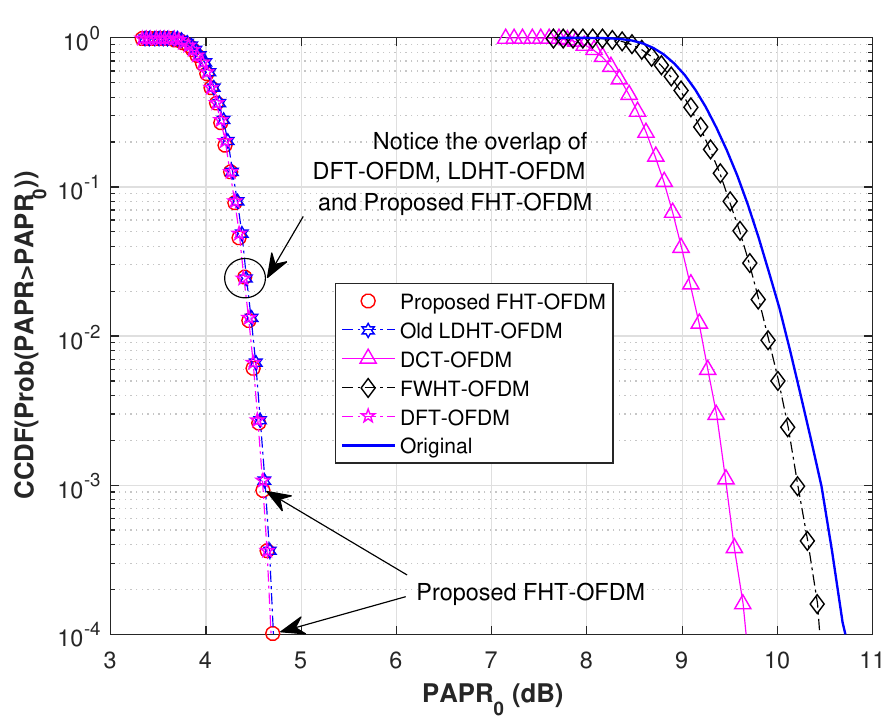
Figure 5. Comparison of the PAPR of the proposed LDHT scheme with other OFDM precoding schemes for N = 512